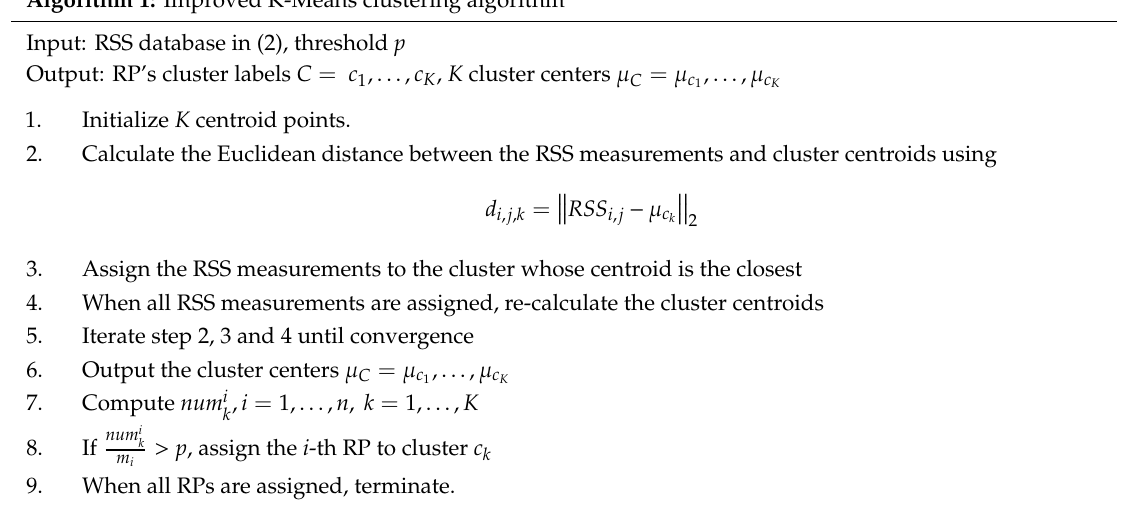
Algorithm 1: Improved K-Means clustering